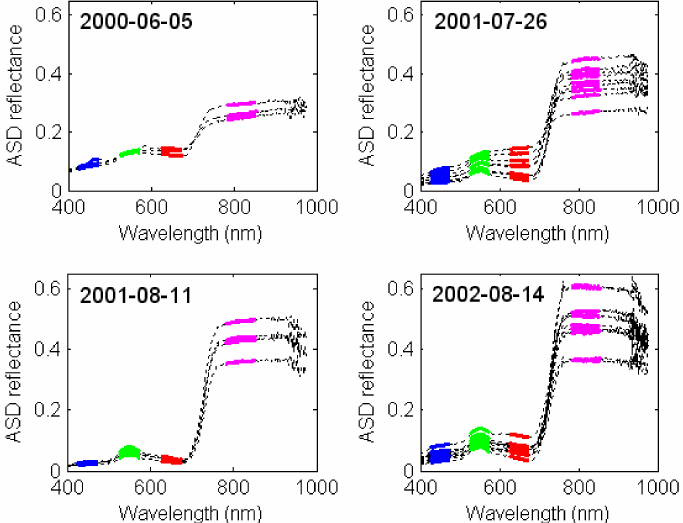
Figure 13. ASD spectroradiometer measurements in agricultural fields located in Mont é r é gie, Quebec, Canada. The blue, green, red, and NIR spectral bands of ETM+ are indicated by blue, green, red, and purple lines,